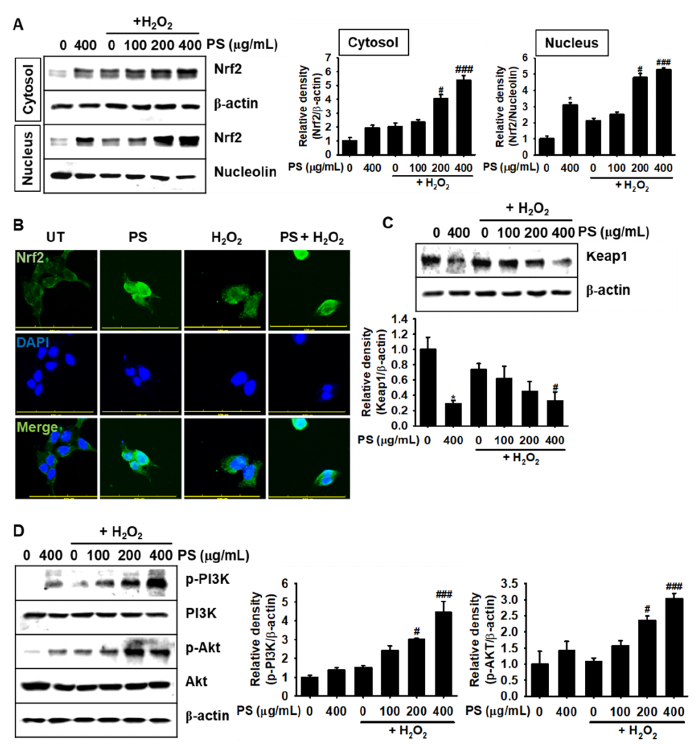
Figure 6. PS promotes the nuclear translocation of Nrf2 in HaCaT keratinocytes in H 2 O 2 -mediated oxidative stress. HaCaT keratinocytes were seeded at a density of 1 × 10 4 cells / mL and treated with the indicated concentrations of PS (0–400 µ g / mL) in the presence and absence of 1000 µ M H 2 O 2 for 4 h. ( A ) Western blotting was performed using cytosolic and nuclear protein fractions against Nrf2 (61 kDa). β -Actin and nucleolin (110 kDa) were used as the internal control for cytoplasmic and nuclear fractions, respectively. ( B ) HaCaT keratinocytes were cultured on 3% gelatin-coated cover slips, and the expression and nuclear translocation of Nrf2 were analyzed by immunofluorescence staining after treatment with PS (400 µ g / mL) in the presence or absence of 1000 µ M H 2 O 2 . In a parallel experiment, Western blotting analysis was performed to assess the expression of Keap1 (69 kDa) ( C ), and pPI3K (85 kDa) PI3K (85 kDa) and pAKT (62 kDa) and Akt (62 kDa) ( D ). β -Actin was used as the internal control along with their respective total forms. Densitometry analysis of each protein was computed by using ImageJ. All data are averaged from three independent experiments and presented as mean ± the standard error of the median [*** p < 0.001 and * p < 0.05 vs. the untreated group (UT) and ### p < 0.001 and # p < 0.05 vs. the H 2 O 2 -treated group]. Scale bars = 100 µ